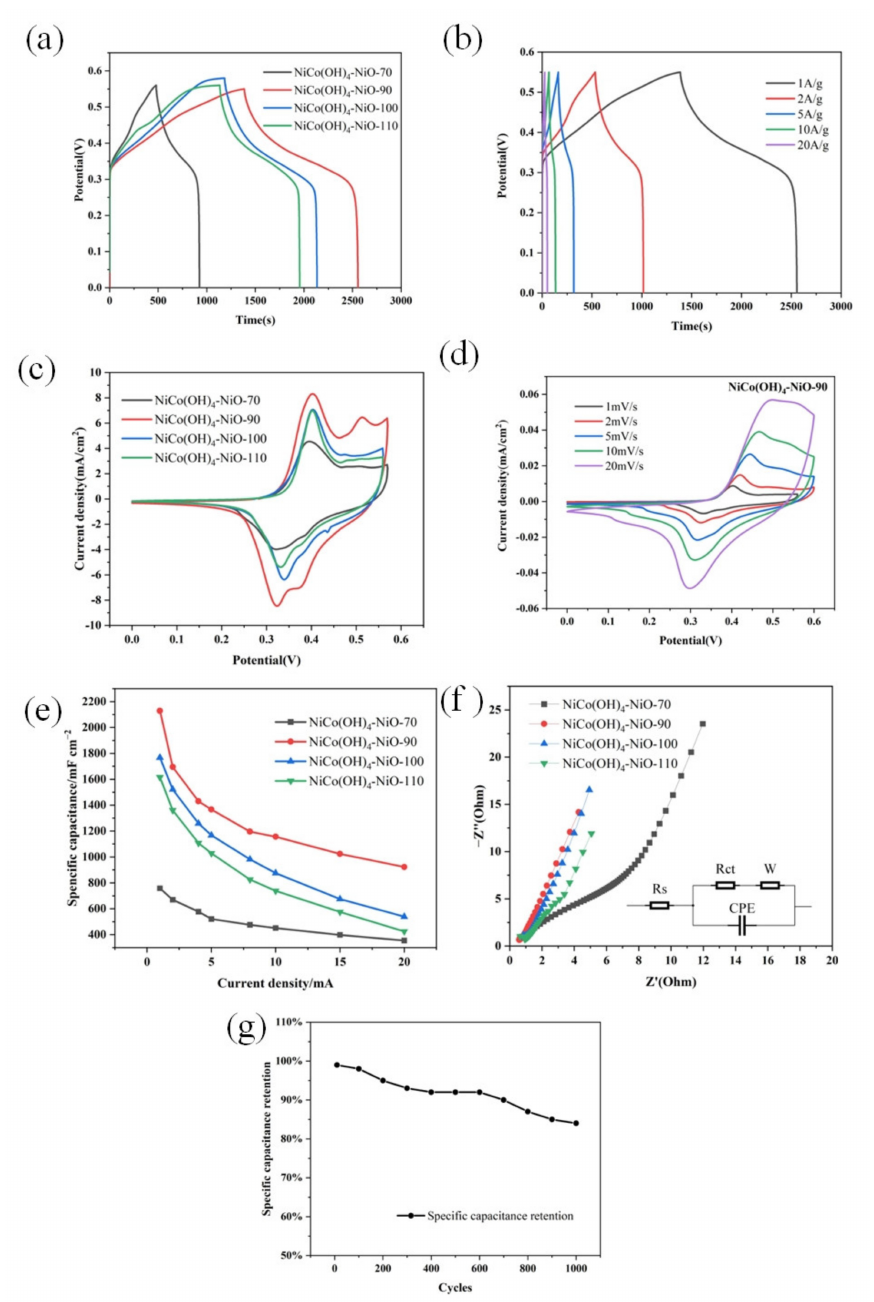
Figure 7. ( a ) Charge–discharge curves of electrode materials prepared at different hydrothermal reaction temperatures at 1 A g − 1 , ( b ) charge–discharge curves of NiCo(OH) 4 -NiO-90 electrode materials at different current densities, ( c ) REDOX reaction of NiCo(OH) 4 -NiO-90 electrode mate- rials at different scanning rates, ( d ) REDOX reaction of electrode materials prepared at different hydrothermal reaction temperatures at 1 mV s − 1 , ( e ) comparison of specific capacitance of electrode materials prepared at different hydrothermal reaction temperatures, ( f ) impedance comparison of electrode materials prepared at different hydrothermal reaction temperatures; the inset shows an equivalent circuit diagram, ( g ) specific capacitance retention of NiCo(OH) 4 -NiO-90 after 1000 charge and discharge